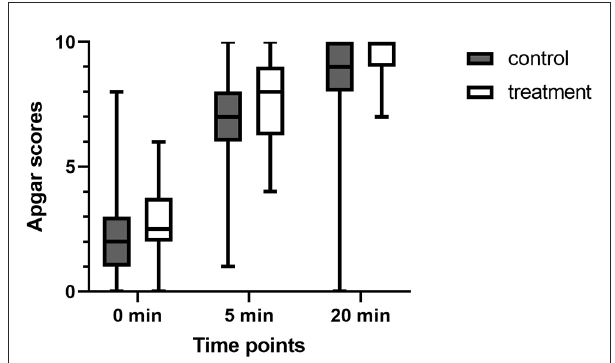
FIGURE2 Comparison of Apgar scores (AS) at 0, 5, and 20min after birth in puppies from dams who received (treatment group) or not (control group) fluid